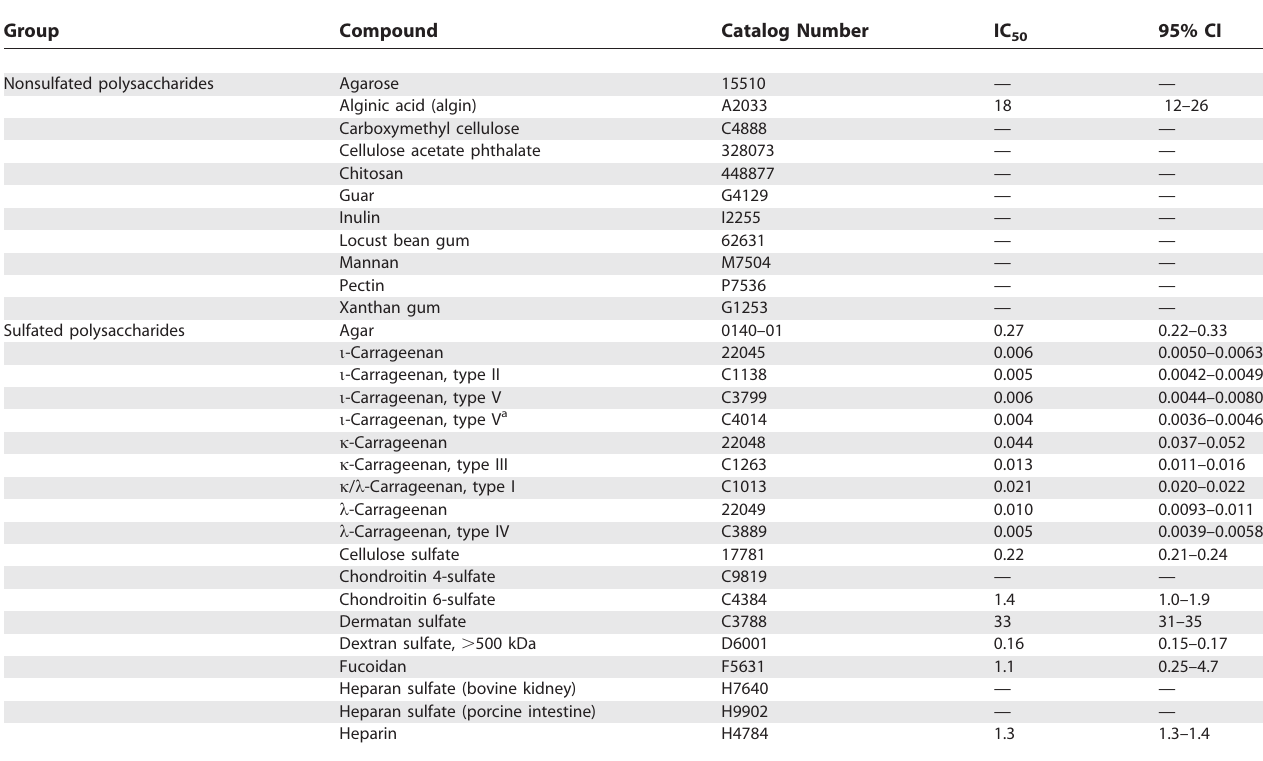
Table 2. Inhibitory Effects of Polysaccharide Compounds